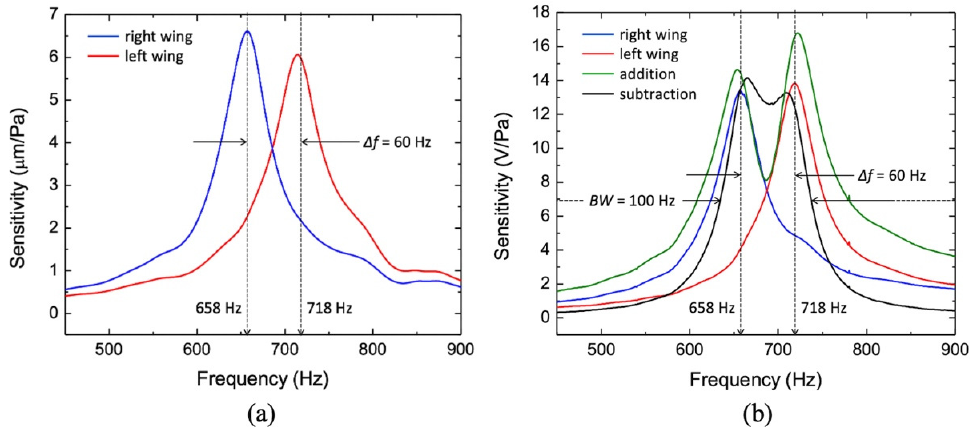
Figure 4. Sensitivity measurements: ( a ) Mechanical sensitivity measured using laser vibrometry at each wing tip separately. ( b ) Electric sensitivity of both wings measured using lock-in amplifiers (blue and red lines). Addition and subtraction of the wings output signals are also shown (black and green line, respectively).